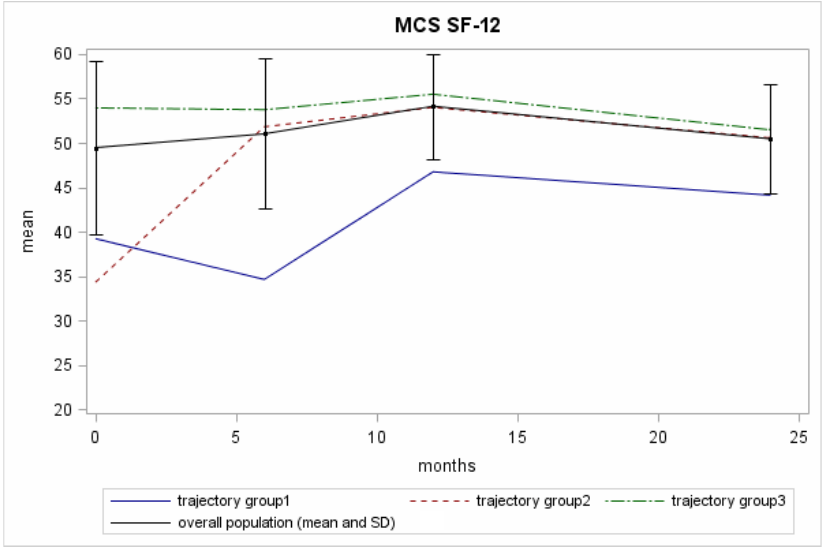
Figure 2. The mean MCS scores across the timeline of the 4 evaluations for the Pros-IT partici-